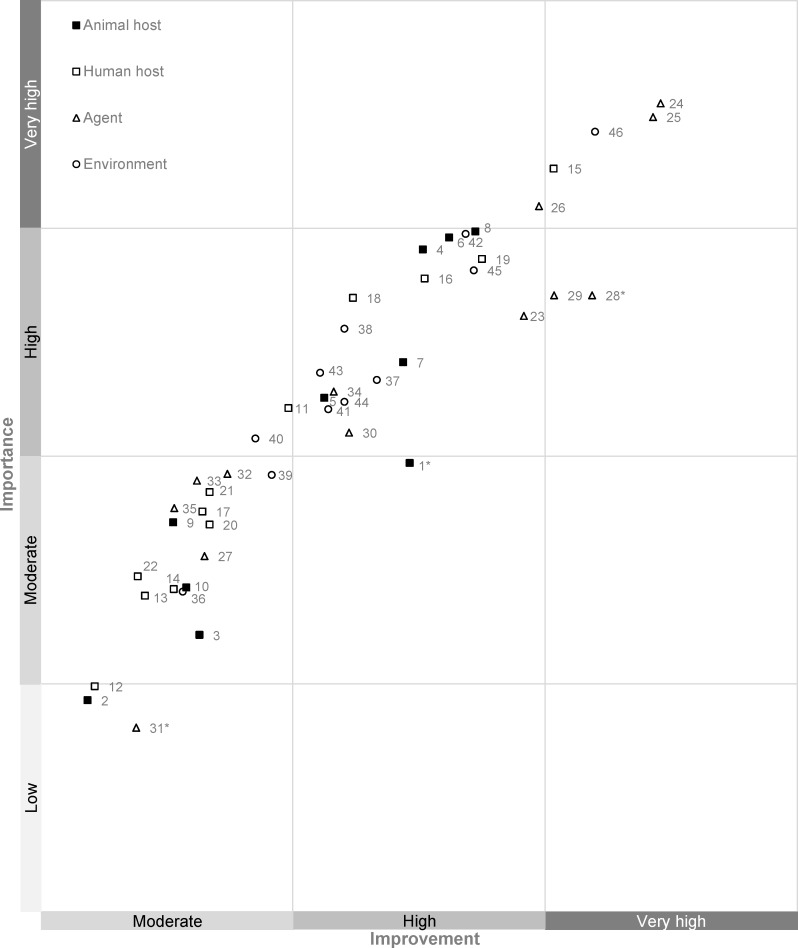
Research needs with high need for improvement are also considered highly important for rabies control.*Significant (p<0.05) difference between the priority group for improvement and importance. Full descriptions of research priorities, corresponding to the numbered value labels, can be found in S1 Table.